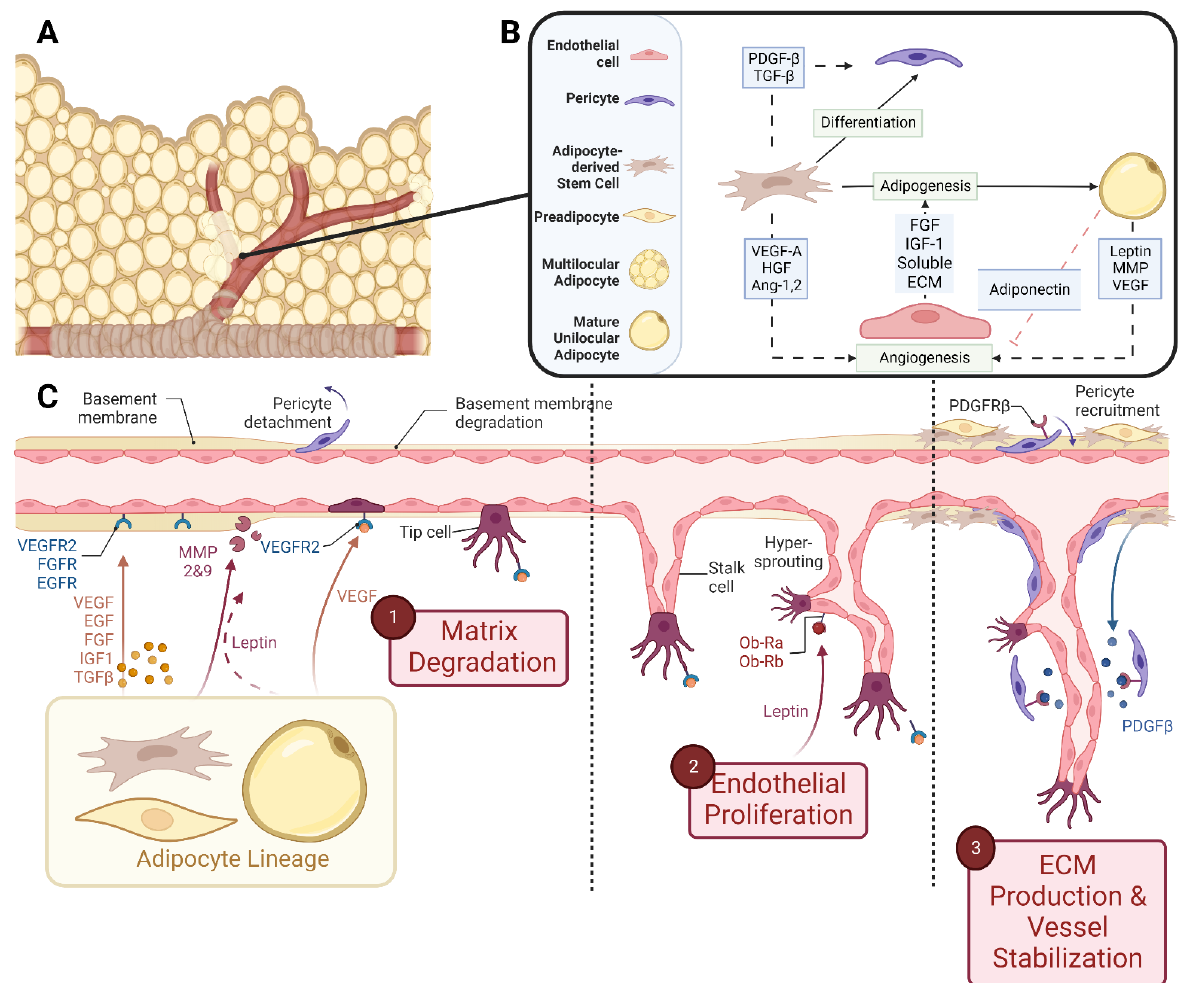
Figure 2. Schematic representations of ( A ) vascularized adipose tissue and ( B ) paracrine interactions between both the vascular and adipose lineages. ( C ) Stepwise breakdown of cellular and paracrine ac- tivity during angiogenesis. Abbreviations: Platelet-derived growth factor- β (PDGF- β ), transforming growth factor- β (TGF- β ), vascular endothelial growth factor-A (VEGF-A), hepatocyte growth factor (HGF), angiopoietin-1,2 (Ang-1,2), fibroblast growth factor (FGF), insulin-like growth factor-1 (IGF-1), extracellular matrix (ECM), and matrix metalloproteinase (MMP). Created with